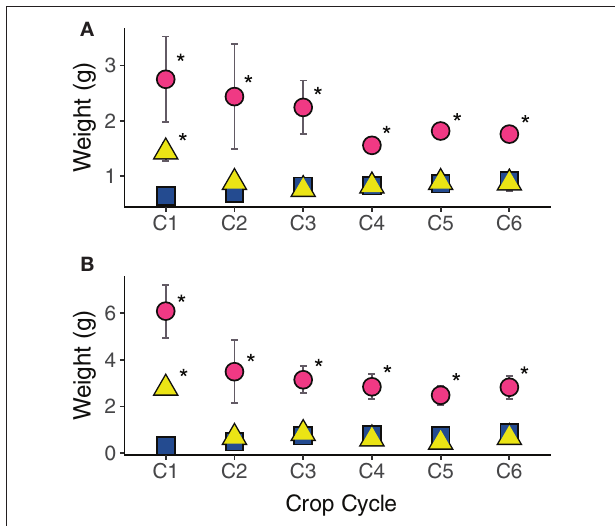
FIGURE 1 | Plant growth response (A) aboveground and (B) belowground to compost (circles) and urea (triangles) fertilization as compared to unfertilized controls (squares) over 6 crop cycles. Asterisks ( * ) denote significant treatment differences within each cropping cycles compared to the control. Error bars indicates standard